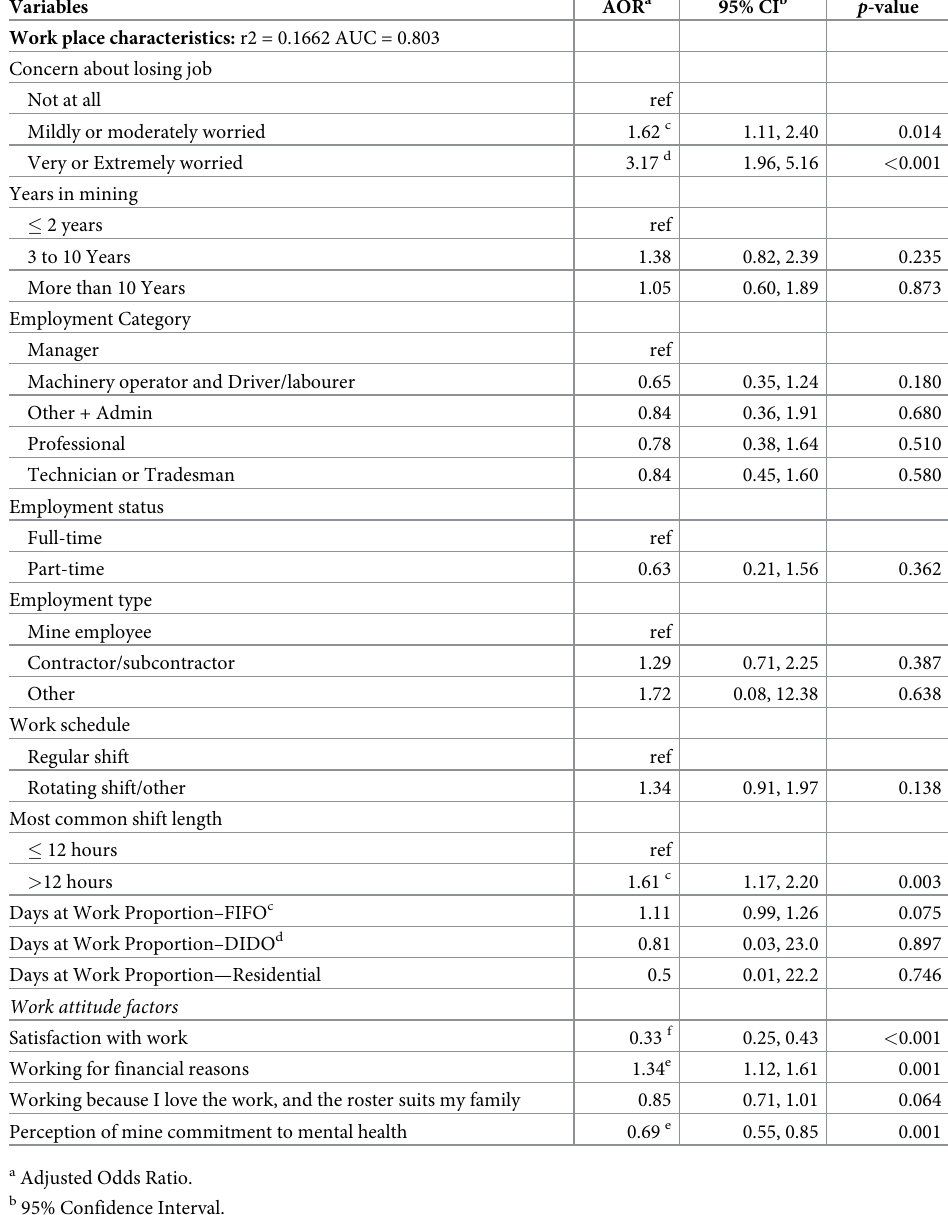
Table 5. Results of multivariable logistic regression models of reporting high and very high psychological distress on workplace characteristics (n = 1543). Variables AOR a 95% CI b p-